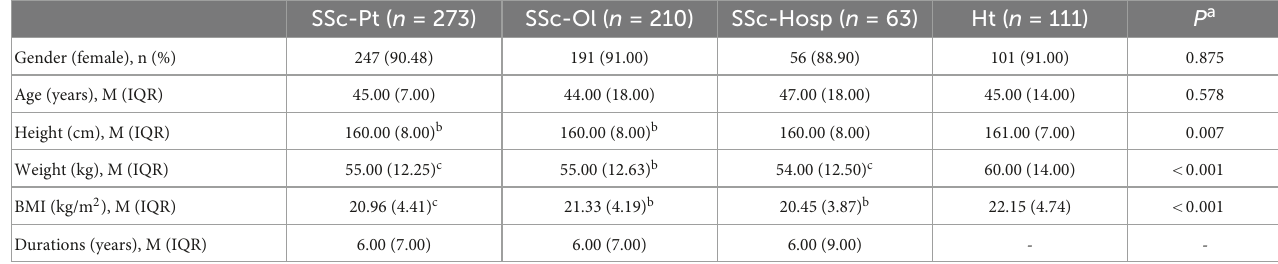
TABLE 1 Demographic